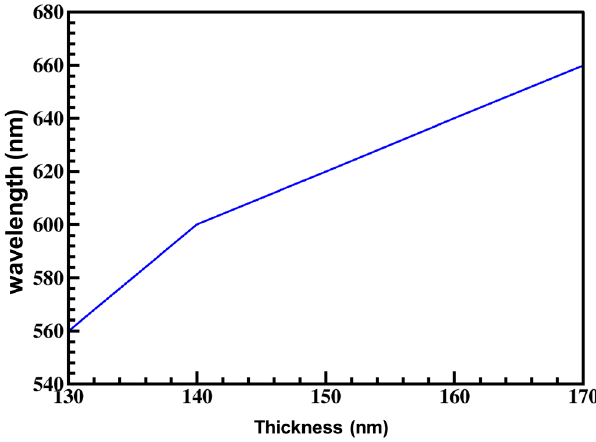
Figure 2. Shift in peak wavelength of a CH geometry with respect to thickness of aluminium film.